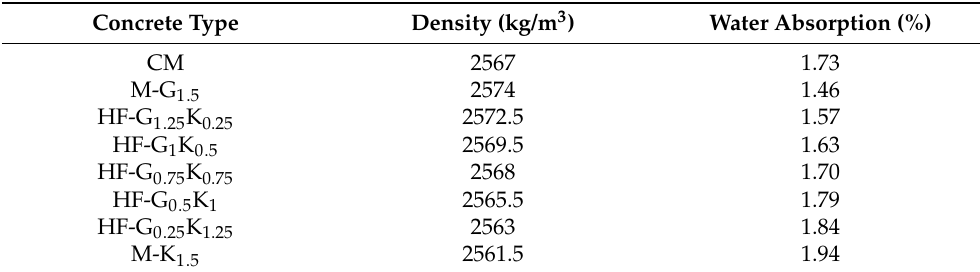
Table 7. Density and water absorption levels of concrete mixes.